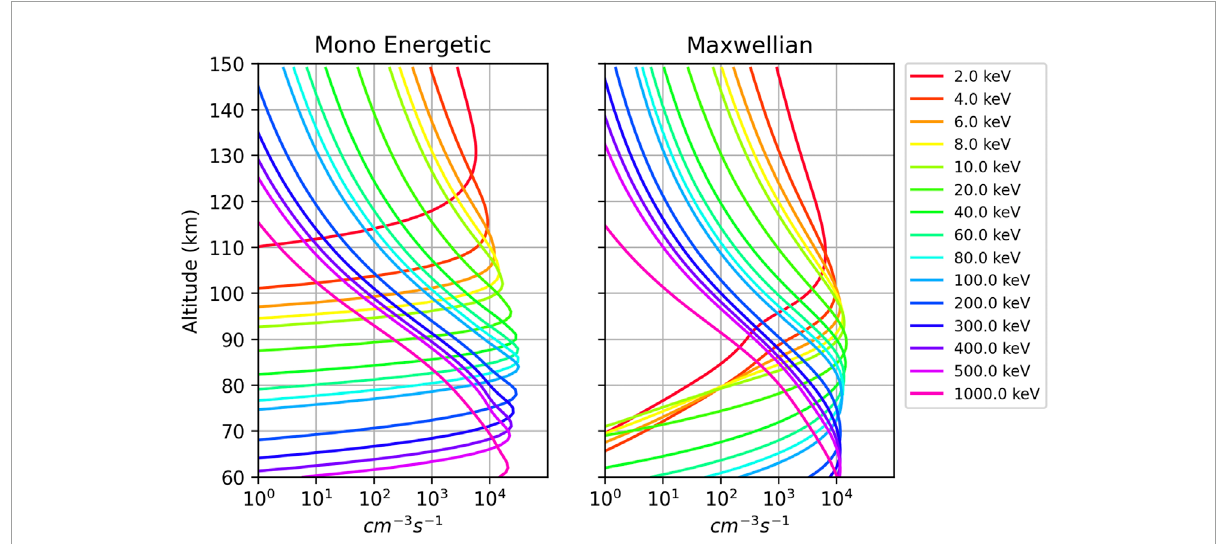
FIGURE 2 The altitude ionization rates for monoenergetic and Maxwellian flux distributions in the left and right columns, respectively. The monoenergetic beam energy and characteristic energy of the Maxwellian distribution are shown in the caption. Both of these cases use a 1 mW / m 2 energy flux.